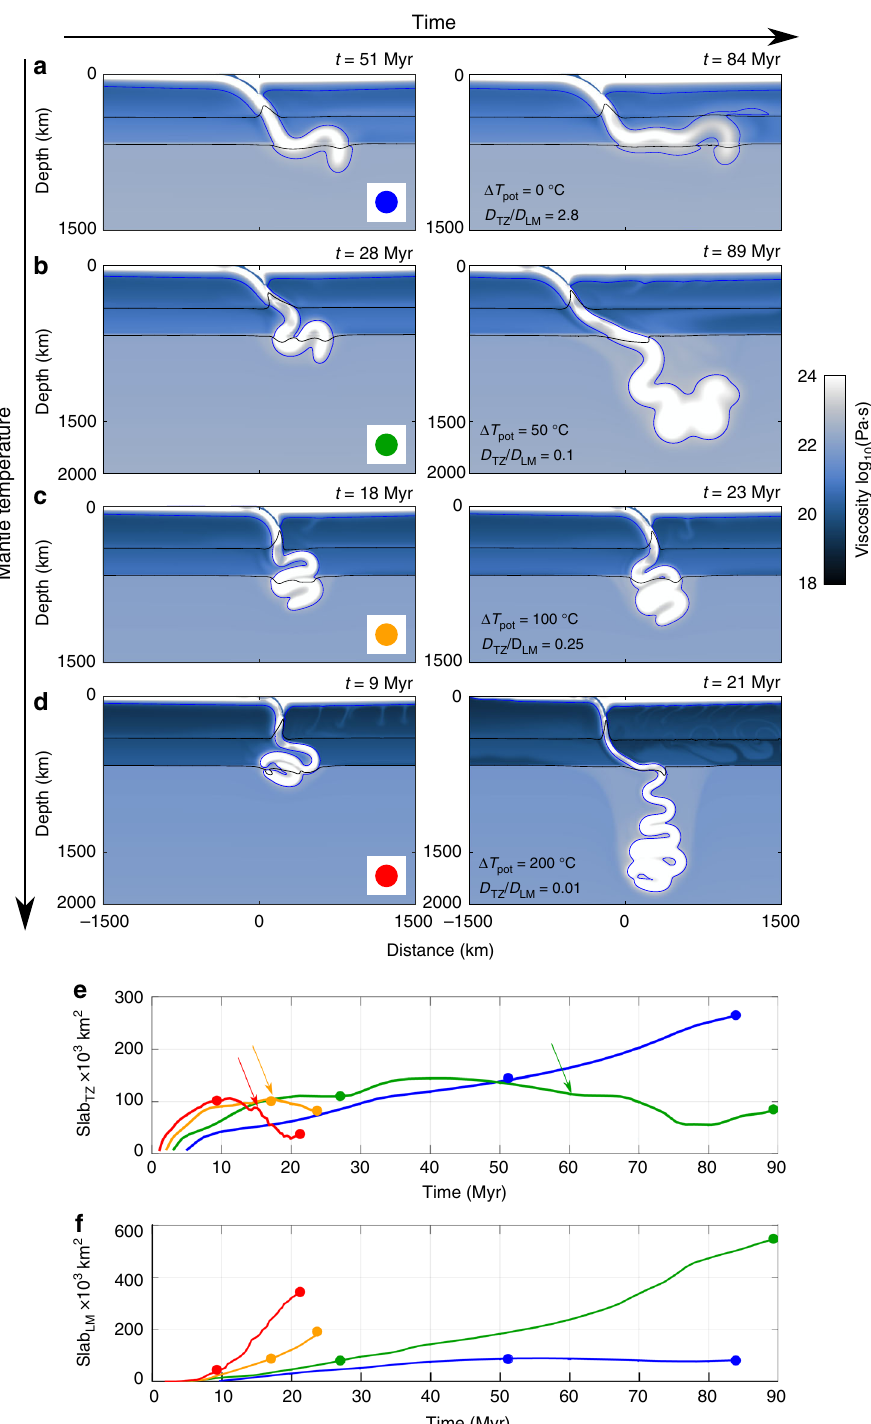
Fig. 3 Penetrating slabs in a hotter mantle. a – d Old (initial age 100 Myr) slab evolution for different mantle temperatures (illustrated by two snapshots each) at strongly negative post-spinel Clapeyron slope ( − 3 MPa ∙ K − 1 ) (Simulations 16, 20, 26 and 32, Supplementary Table 1): a present-day temperature, Δ T = 0 °C (blue), b Δ T = + 50 °C (green), c Δ T = + 100 °C (orange), d Δ T = + 200 °C (red). This colour coding is subsequently used in e , f , and pot pot pot pot Fig. 4. For each case the value of D TZ / D LM is indicated. The evolution of slab material in the transition zone Slab TZ ( e ) and lower mantle Slab LM ( f ). The arrows in e indicate the approximate timing of accelerated lower-mantle slab sinking events in the hotter mantle models. The dots mark the timing of the snapshots in a –